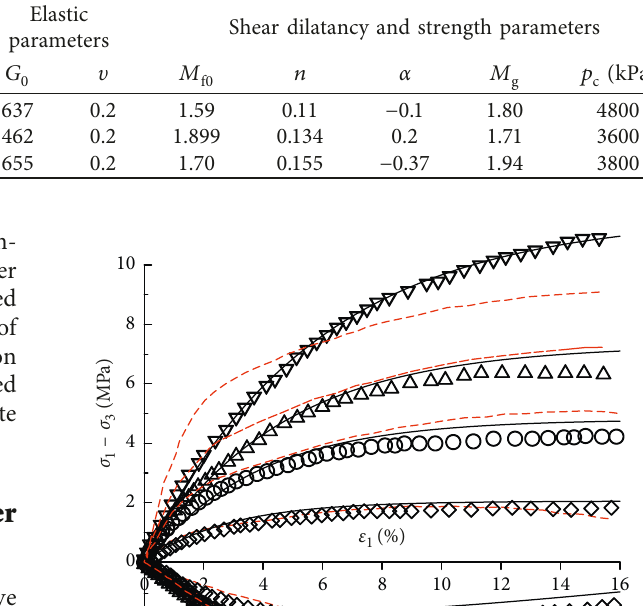
Table 1: Constitutive model parameters of three different rockfill materials.